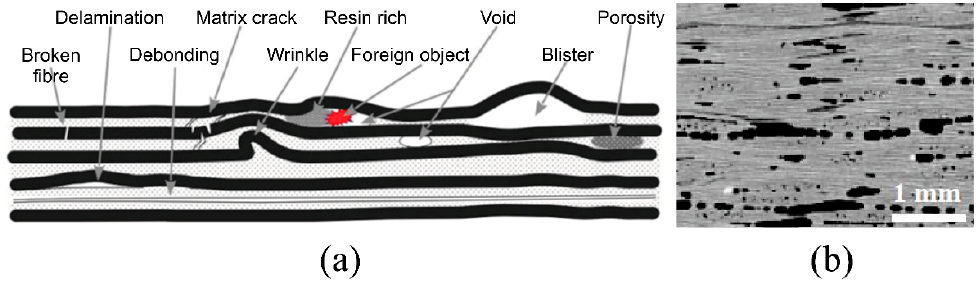
Figure 2. Defects in fiber-reinforced plastic laminates: ( a ) Schematic of common lamination defects [18]; ( b ) X-ray CT image of defects in carbon-fiber-reinforced plastic laminate [19].